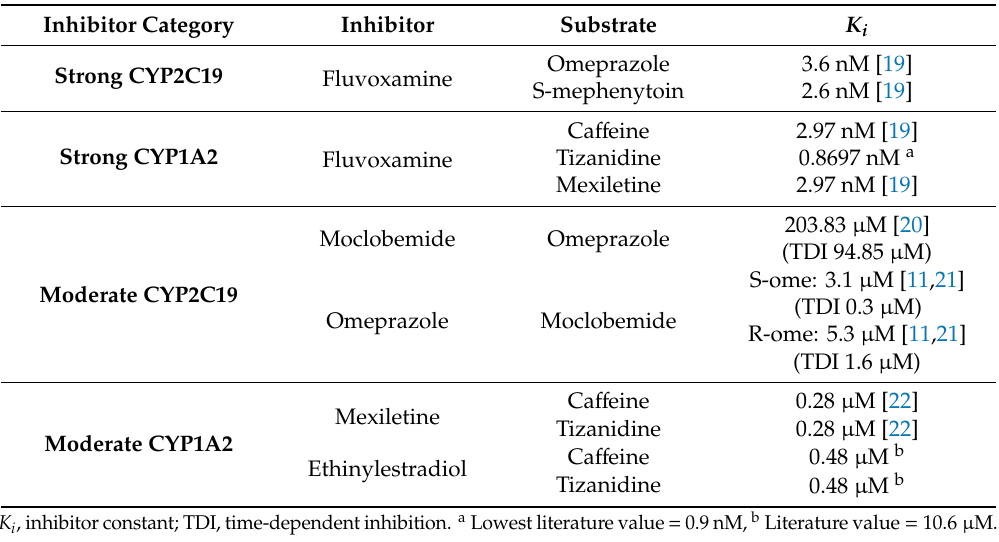
Table 4. Overview of K i values used in the DDI